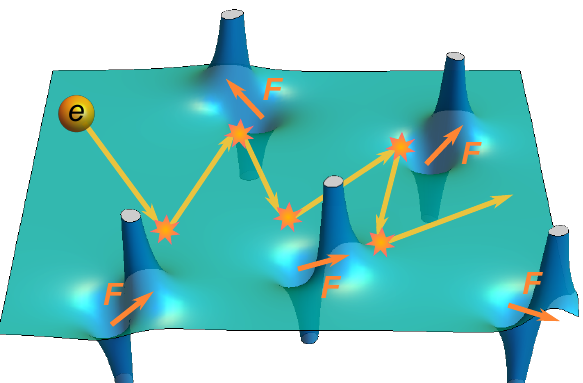
Figure 1: Schematic visualization of the proposed scattering mechanism. Electrons scatter on deformation potential induced by local vector impurities. The local vectors F are oriented randomly for different